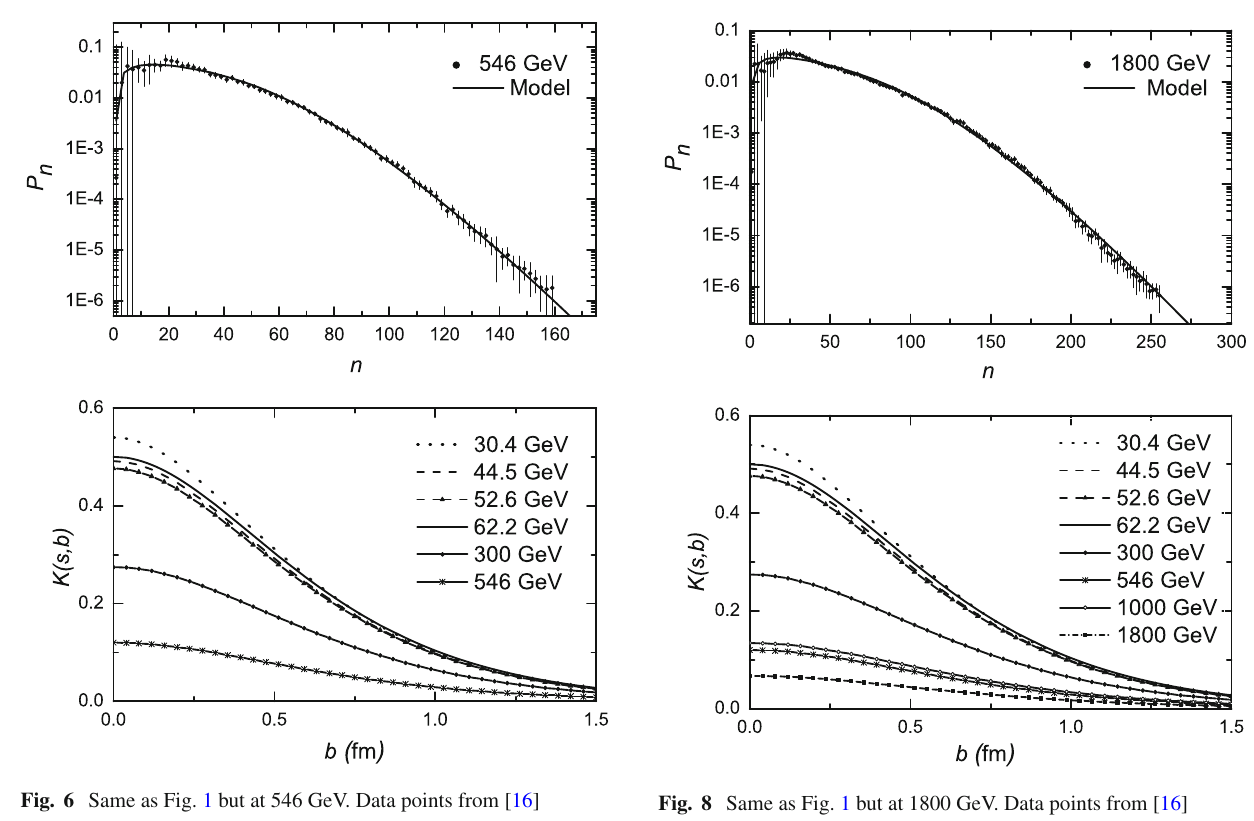
Fig. 8 Same as Fig. 1 but at 1800 GeV. Data points from